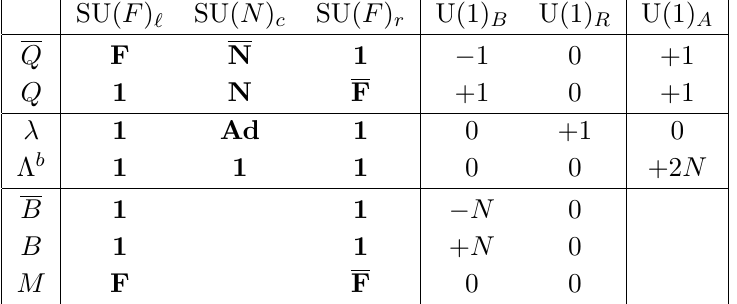
Table 1 . Transformations of the superfields Q , Q , M , B and B , under the gauged and global symmetry groups for the F = N case of SQCD. Also shown are the R charge of the gauginos ( λ ), and the transformation of Λ b under the spurious U(1) A . Here N and N indicate the fundamental and antifundamental representations of SU( N ) , while Ad indicates the adjoint representation. The U(1) R charges shown are those of the scalar component of the superfields. At scales well above the scale | Λ | , U(1) A is approximately conserved, but it is broken explicitly when SU( N ) c is gauged. The infrared theory is valid only for scales well below Λ , where U(1) A is badly broken, so we do not list the U(1) A charges of the gauge-invariant operators M , B , or B